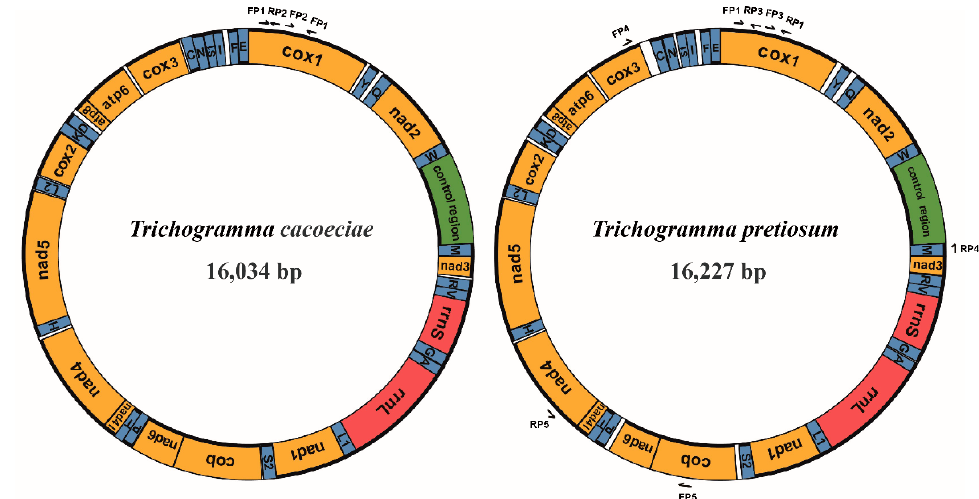
Figure 1. Structures of Trichogramma cacoeciae and T. pretiosum mitochondrial genomes. Yellow indicates mitochondrial protein-coding genes. Red indicates mitochondrial ribosomal RNAs. Blue indicates mitochondrial tRNAs. Green indicates the control region, which is also known as the D-loop region, major noncoding region, or A + T-rich region. Genes on the inner loop are encoded on the major strand, while those on the outer loop are on the minor strand. Arrows indicate primers used for mitochondrial PCR amplification. FP: forward primer; RP: reverse primer.